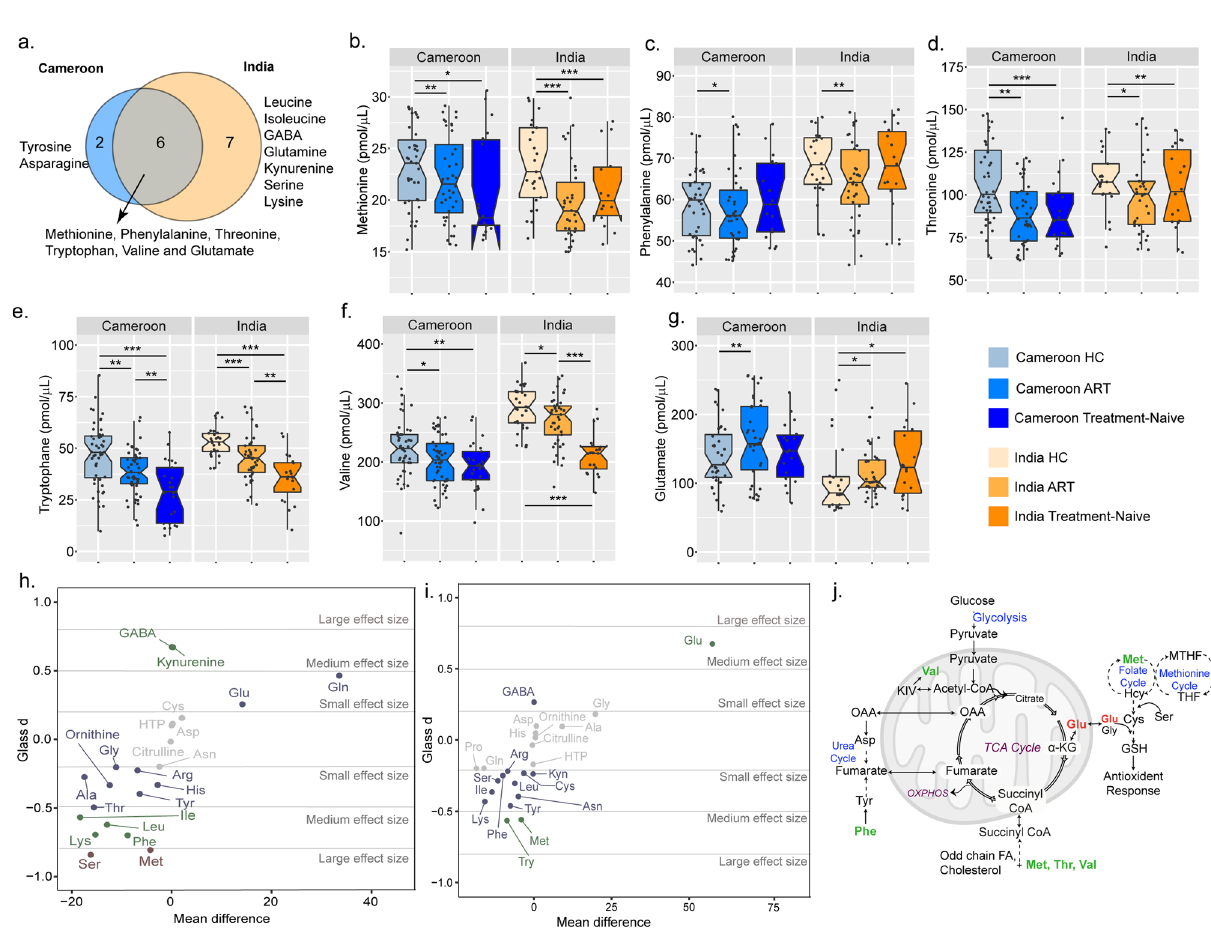
Fig. 3 Targeted amino acid in the larger HIV-1 cohorts from Cameroon and India. a Venn diagram representing the overlap of AA signi fi cantly differing in HC compared to cART between Cameroon and Indian cohort. b – g Box plots showing the abundance of six signi fi cant AA between HC and cART (Mann – Whitney U -test, FDR < 0.1) (*FDR < 0.1, **FDR < 0.05, ***FDR < 0.01): methionine ( b ), phenylalanine ( c ), threonine ( d ), tryptophan ( e ), valine ( f ), and glutamate ( g ) in HC, and PLWH on cART and treatment-naive patients from Cameroon and Indian cohorts. Cameroon HC (light blue) n = 50; Cameroon cART (blue) n = 50; Cameroon Treatment-Naïve (dark blue) n = 25; India HC (light yellow) n = 30; India cART (light orange) n = 41; India Treatment-naïve (orange) n = 20. h and i Scatter plot of AA mean differences by effect size (Glass delta ( D )) in Indian ( h ) and Cameroon ( i ) cohorts. Dots are colored based on effect size (red = large, green = medium, blue = small). j Schematic representation of the altered AA linked with the key metabolic